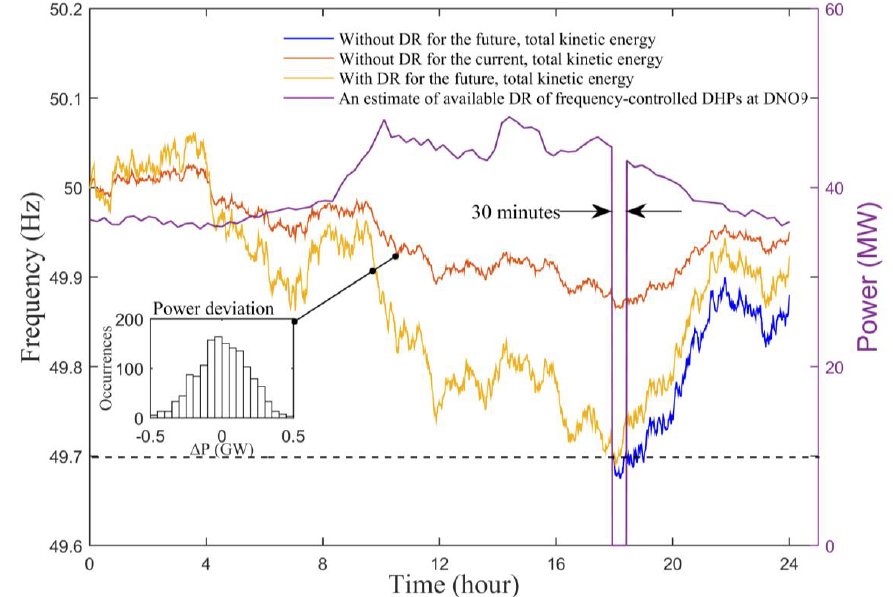
Figure 7. System frequency (i.e., based on normal probabilistic deviations between supply and demand) without and with the static DR controller using demand reduction of frequency-controlled DHPs at DNO9 only.